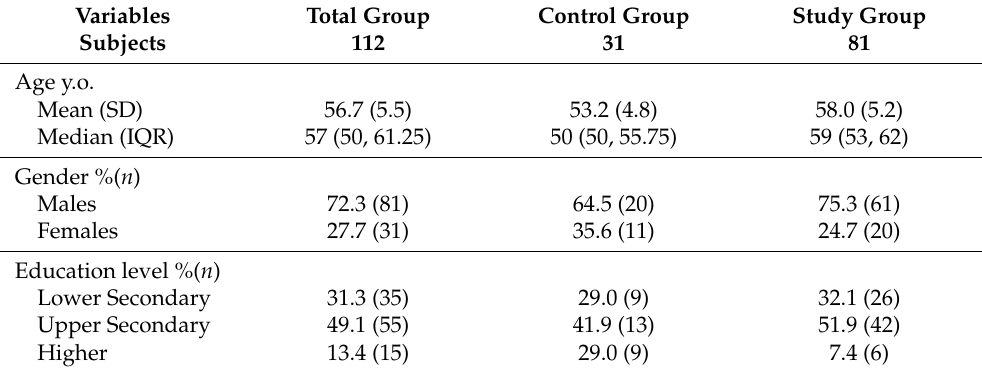
Table 1. Demographic features and educational levels in the study group and control group.